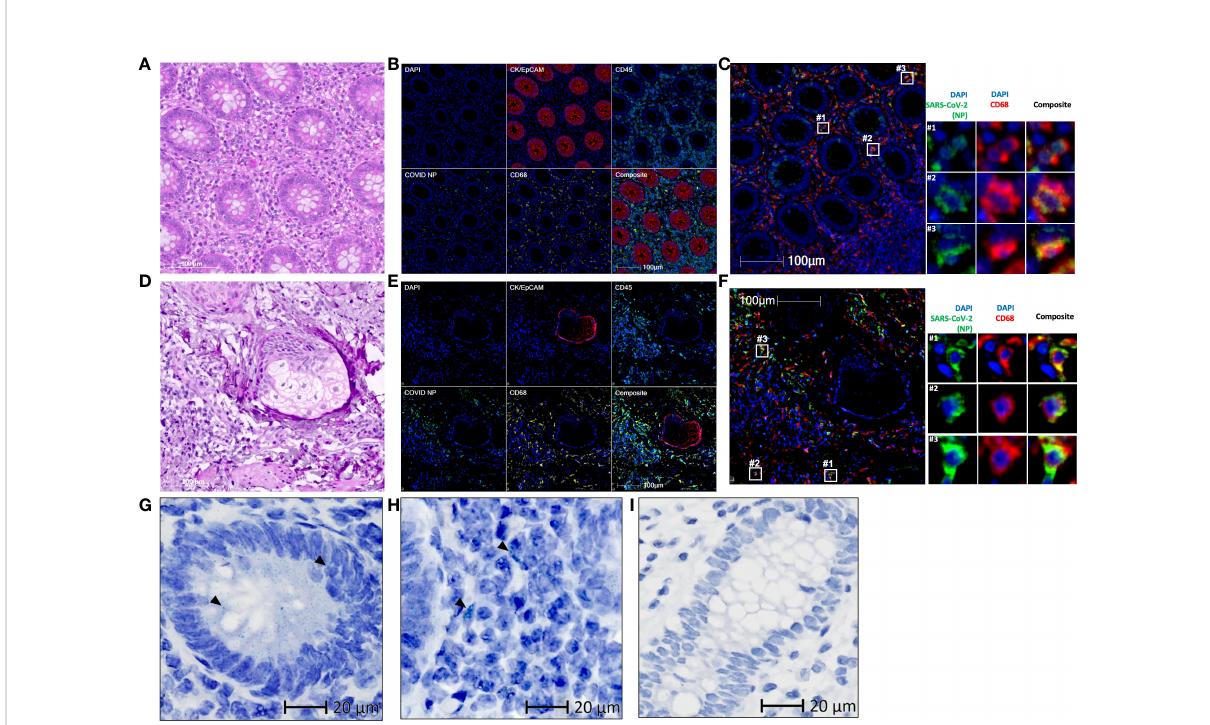
FIGURE 1 Residual SARS-CoV-2 detected in the appendix and skin tissues of patient 1 using multiplex immunohistochemistry and RNAscope (A, D) Representative images of the (A) appendix and (D) skin tissues stained with hematoxylin and eosin, with differentiated staining of nuclear (hematoxylin) and cytoplasmic (eosin) components. (B, E) Representative images of the (B) appendix and (E) skin tissues stained for DAPI (blue), CK/EpCAM (red), CD45 (cyan), SARS-CoV-2 nucleocapsid protein (COVID NP; green), and CD68 (yellow). (C, F) Representative images of the (C) appendix and (F) skin tissues stained for DAPI (blue), SARS-CoV-2 nucleocapsid protein (COVID NP; green), and CD68 (red). (G – I) Representative images of the (G, H) appendix tissue obtained from patient 1 and (I) normal colon tissue obtained from patients not affected by COVID-19, subjected to RNAscope in situ hybridization with a nuclear component (hematoxylin) counterstained. SARS-CoV-2 spike RNAs are labelled as green dots, examples of the green dots are marked by black arrows. (A – F) Scale bar, 100 m m. (G – I) Scale bar, 20 m